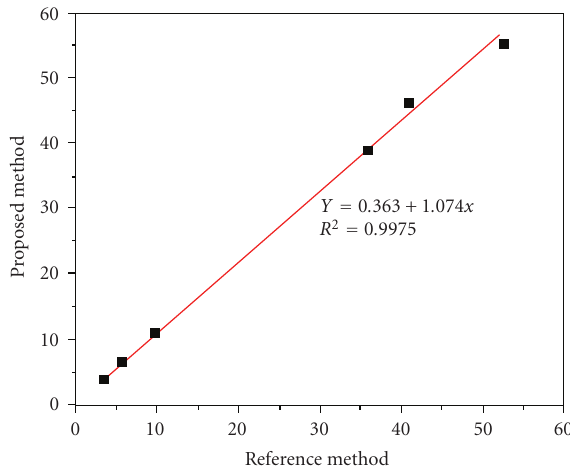
Figure 6: Relationship between proposed and the reference method used for total phenolic compounds